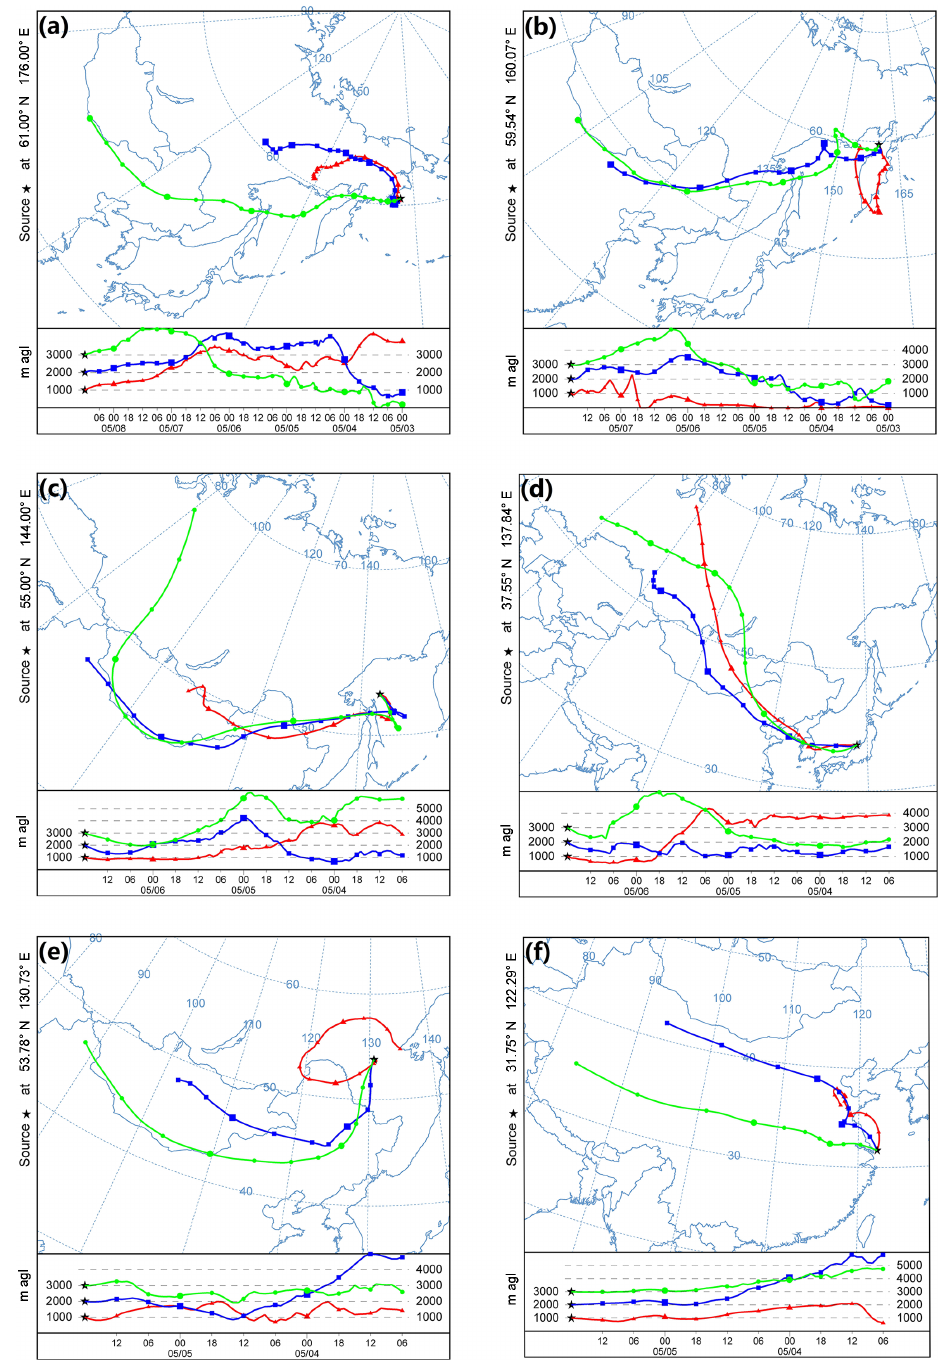
Figure 5. Backward trajectories derived from the HYSPLIT model at different locations during 5–8 May 2017: (a) 132h back trajectories ending at the Bering Sea on 8 May, (b) 108h back trajectories ending at the Kamchatka Peninsula on 7 May, (c, d) 84h back trajectories ending at the Sea of Okhotsk and the Sea of Japan on 6 May, respectively, and (e, f) 60h back trajectories ending at south-eastern Russia and the Yangtze River estuary region on 5 May,